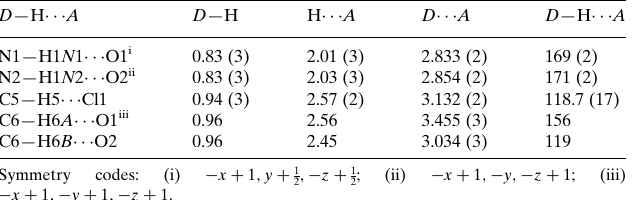
Hydrogen-bond geometry (A˚ , (cid:4)